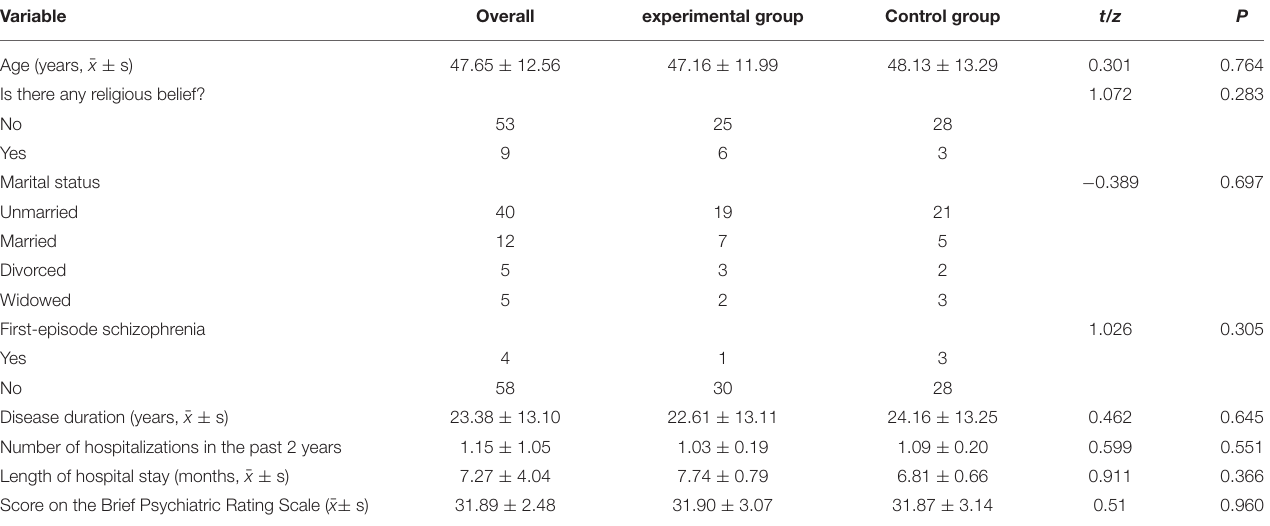
TABLE 3 | Demographic data of the control group and experimental group.